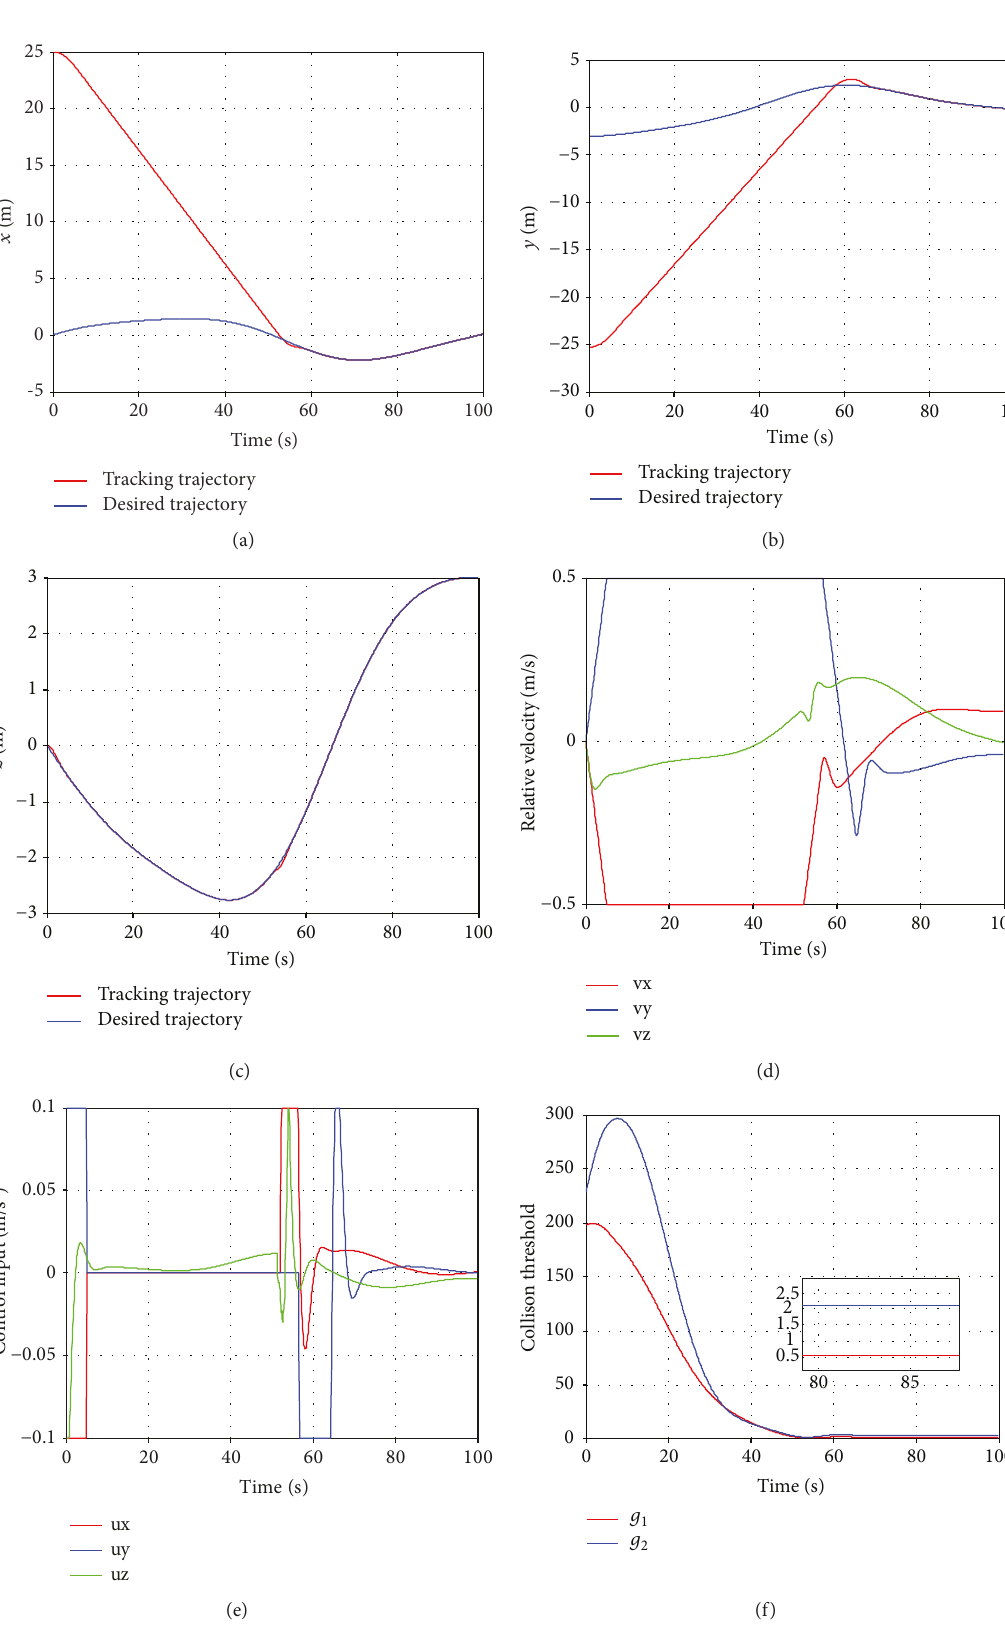
Figure 6: Temporal response of the relative position, relative velocity, control input, and collision threshold. (a) Temporal history along the x direction. (b) Temporal history along the y direction. (c) Temporal history along the z direction. (d) Temporal history of relative velocity. (e) Temporal history of the control input. (f) Temporal history of the collision